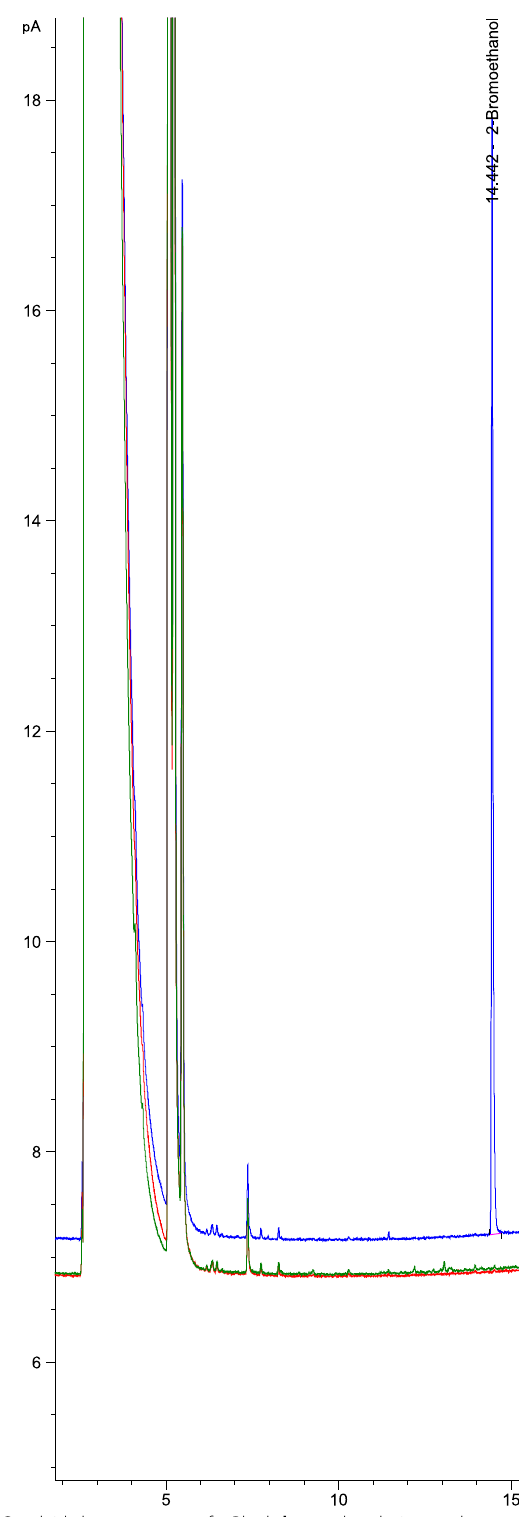
Fig. 3 Overlaid chromatogram of a Blank, b sample solution, and c standard